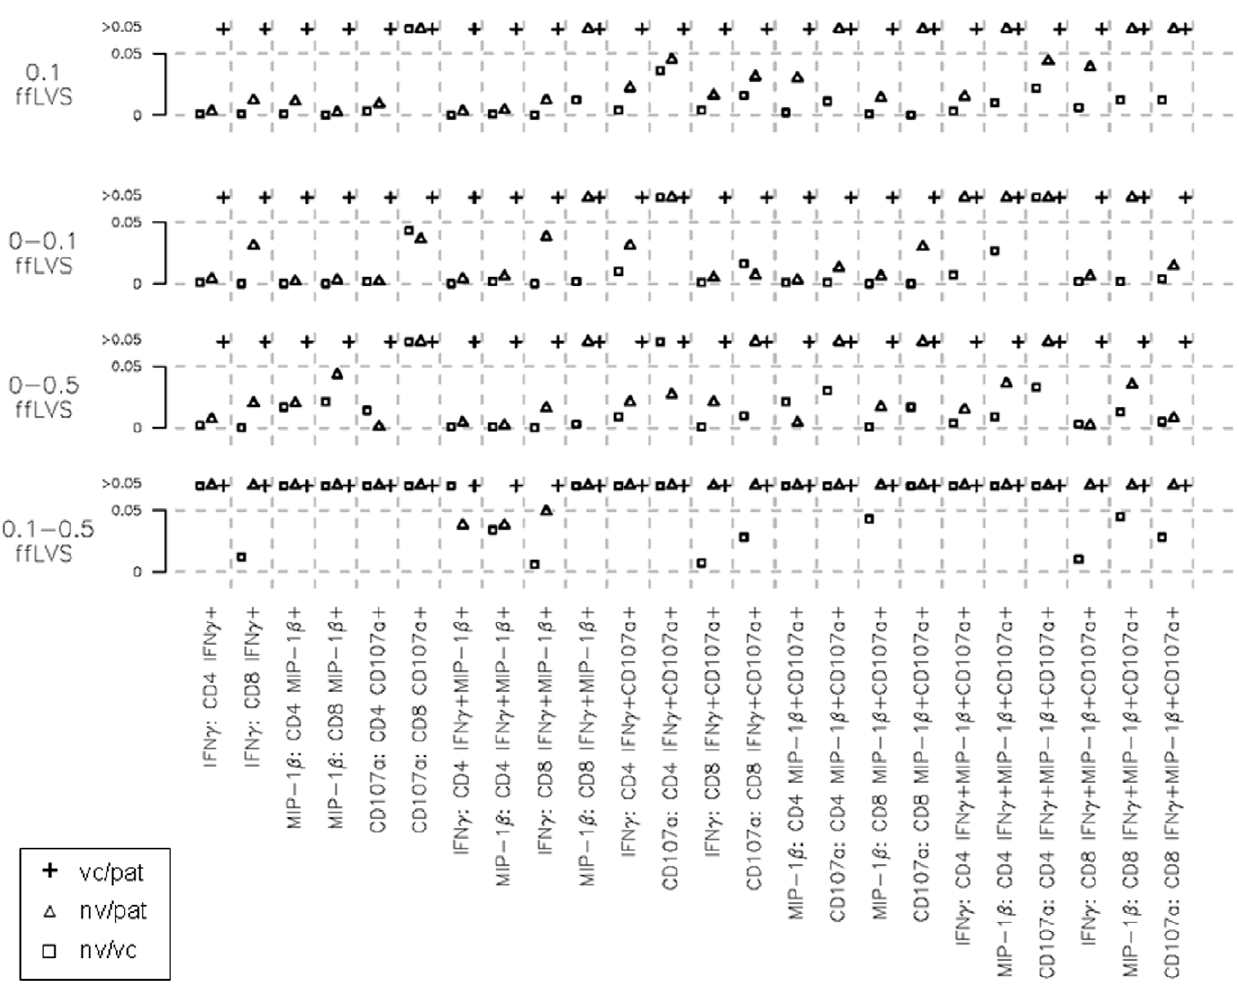
Figure 7. Probability values for comparisons of iMFI data for intracellular markers in various T-cell subsets after recall stimulation. Integrated MFI values were obtained for all three functional markers (IFN- c , MIP-1 b , CD107a) in all mono-, bi- and trifunctional T-cell subsets (24 values per PBMC sample) and for all donors using Clust semi-automated gating. Median iMFI values after stimulation with 0.1 cfu ffLVS/PBMC or the median antigen-dependent increases of the iMFI were analyzed for statistically significant differences between donor groups (5–10 naı¨ve